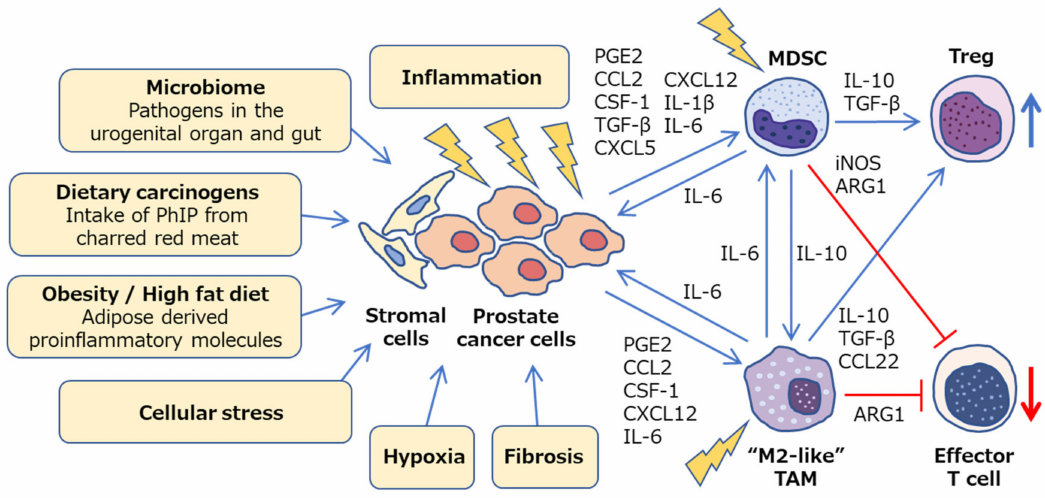
Figure 2. Inflammatory microenvironment in prostate cancer. Diverse mechanisms, such as microbiome, dietary carcinogens, obesity, cellular stress, hypoxia and fibrosis, can be a potential cause of inflammation in prostate cancer. Crosstalk between cancer cells, stromal cells, and immune cells promotes chronic inflammation and facilitates prostate cancer progression via a variety of intercellular signaling molecules. Prostate tumor microenvironment is generally considered to be immunologically “cold” as M2-like TAMs and MDSCs cooperatively inhibit e ff ector T cells and activate regulatory T cells. PhIP, 2-amino-1-methyl-6-phenylimidazo [4,5-b]pyridine; PGE2, prostaglandin E2; CSF-1, colony stimulating factor-1; TGF- β , transforming growth factor- β ; ARG1, arginase 1; iNOS, inducible nitric oxide synthase; TAM, tumor-associated macrophage; MDSC, myeloid-derived suppressor cell; Treg, regulatory T